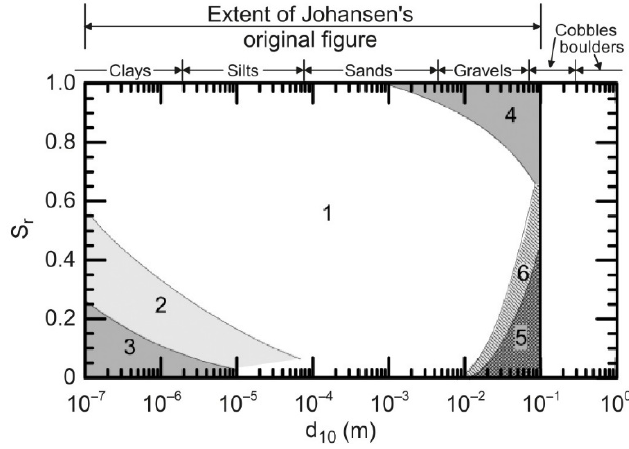
Figure 2. Heat transfer mode in soils (redrawn and adapted from Johansen (1975) [2] and Côté et al., (2011) [6]).